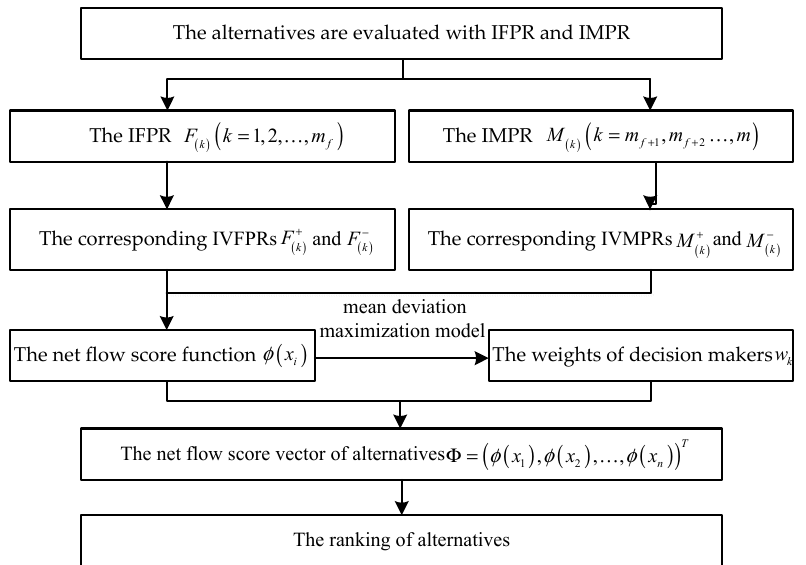
Figure 1. Flow diagram of the proposed method. IFPR: intuitionistic fuzzy preference relations. IMPR: intuitionistic multiplicative preference relations. IVFPRs: interval-valued fuzzy preference relations. IVMPRs: interval-valued fuzzy preference relations.